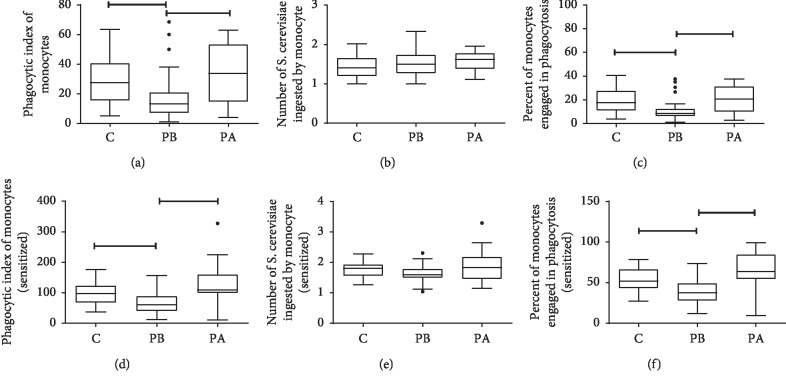
Phagocytic capacity of monocytes/macrophages obtained from peripheral blood of control subjects (C n = 27) or with periodontitis (P n = 28) before (PB) and after (PA) the mechanical removal of plaque. The cells were incubated with S. cerevisiae sensitized with fresh human serum (opsonin phagocytosis) or with inactivated FBS (phagocytosis for pathogen-associated molecular patterns) to determine the phagocytic index (PhI) (a, d), which is the product of the phagocytosed yeasts/cell mean (b, e) by the % of cells involved in phagocytosis (c, f). Before therapy, the results showed lower PhI in the periodontitis group than in the control group for both phagocytosis by opsonins and by pathogen-associated molecular patterns (Mann–Whitney, p < 0.05); the paired analysis showed that treatment of the individuals increased the PhI in the periodontitis group (PA > PB) by the two pathways of phagocytosis (Wilcoxon, p < 0.05). The medians, quartiles, and maximum and minimum values are shown.